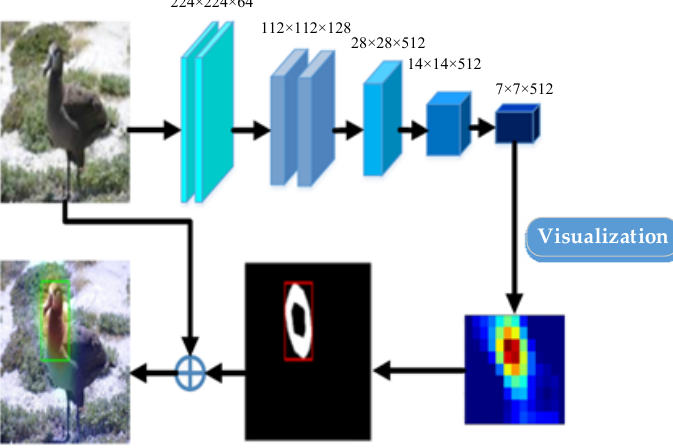
Figure 4. Saliency module based on weakly supervised